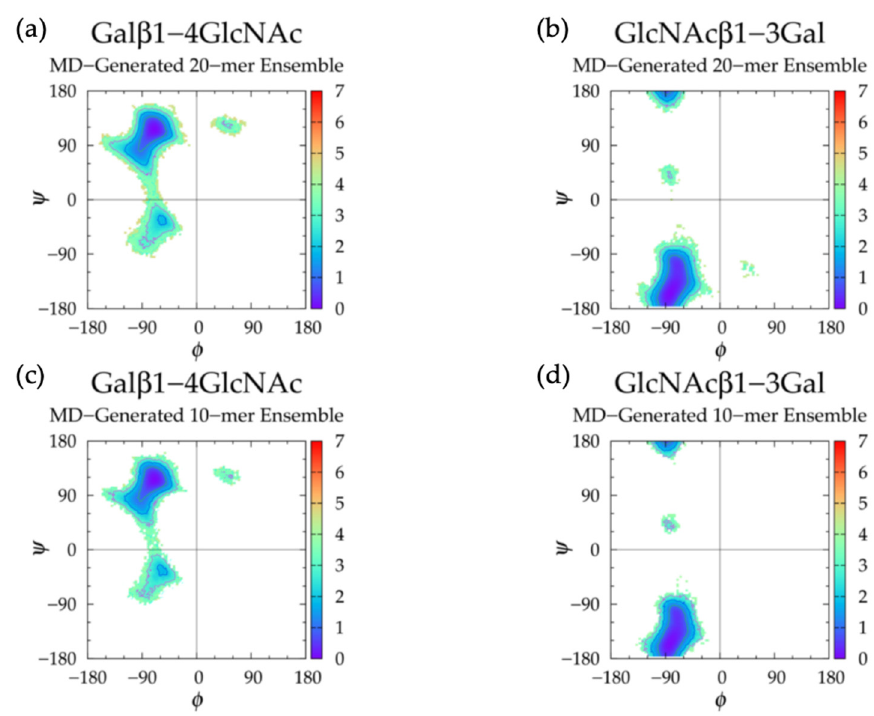
Figure 16. Δ G ( ϕ , ψ ) in the MD-generated nonsulfated keratan ensembles for aggregated Gal β 1-4GlcNAc and GlcNAc β 1-3Gal glycosidic linkage data in the ( a , b ) 20-mer and ( c , d ) 10-mer, respectively; contour lines every 1 kcal/mol. Table 6. Nonsulfated Keratan Glycosidic Linkage Dihedrals ( ϕ , ψ ) 1 and Free Energy ( Δ G ( ϕ , ψ ) kcal/mol) Minima.